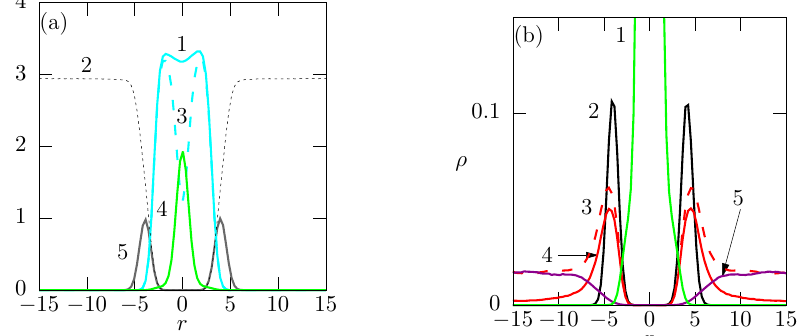
Figure 3. ( a ) Density profiles of phospholipid bilayer (system No. 1, see Table 2): 1 (cyan solid)—profiles of hydrophobic lipid tail, 2 (gray dashed)—solvent profile, 3 (cyan dashed)—hydrophobic beads (except the end beads), 4 (green solid)—noncharged end-bead profile, 5 (gray solid)—noncharged lipid heads profile; ( b ) Density profiles of charged end-groups and monovalent ions in the same systems No. 1 and 2 (Table 2): 1 (green solid)—noncharged end-bead profile, 2 (black solid)—negatively charged lipid head profile, 3 (red solid)—monovalent cations Na (20%), 4 (red dashed)—monovalent cations (10%), 5 (purple solid)—monovalent anions Cl